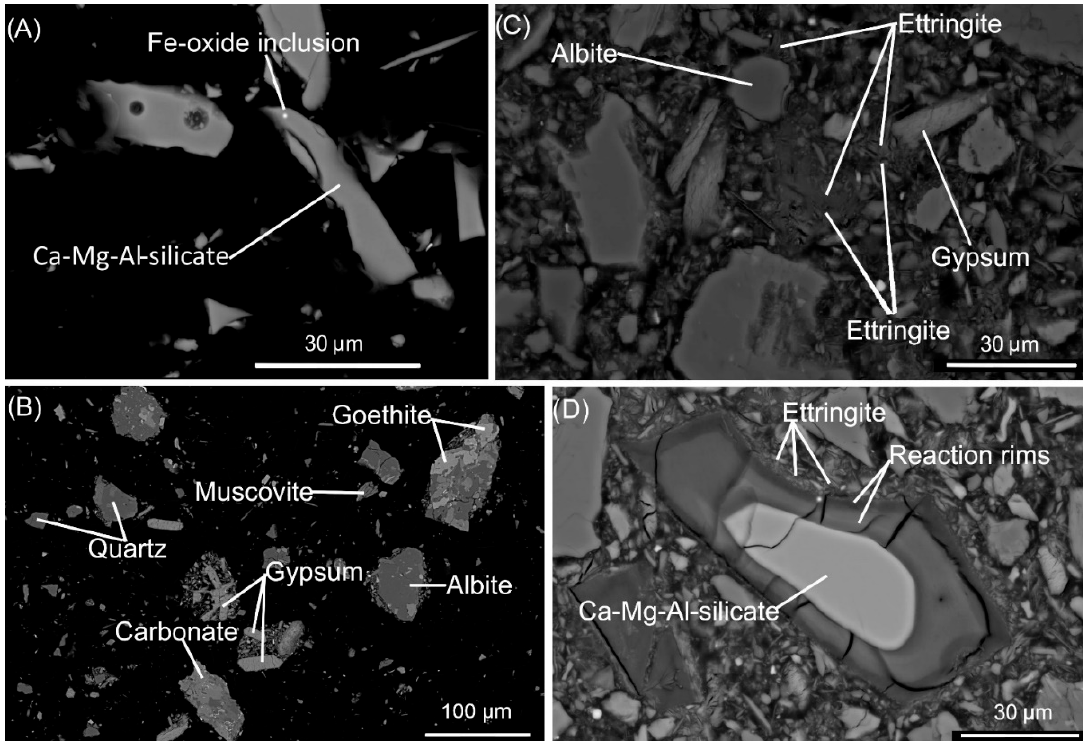
Figure 1. Back-scattered electron (BSE) images of the studied materials. ( A ) Slag sample (Ca-Mg-Al-silicate), with a characteristic Fe-oxide inclusion. ( B ) Tailings sample showing lithic fragments composed mainly of quartz, albite, and carbonate. Some liberated gypsum and muscovite grains are also shown in the image. ( C ) Sample R4, with ettringite filling spaces in the matrix and grows along the boundaries of other minerals such as albite (marked in the image). ( D ) Sample R3. Grain of Ca-Mg-Al-silicate (slag), with an unreacted core (bright) and reaction rims (darker grey) that are obviously hydrated (notice abundant drying cracks, and an evaporated hole after the electron beam on the lower right-hand